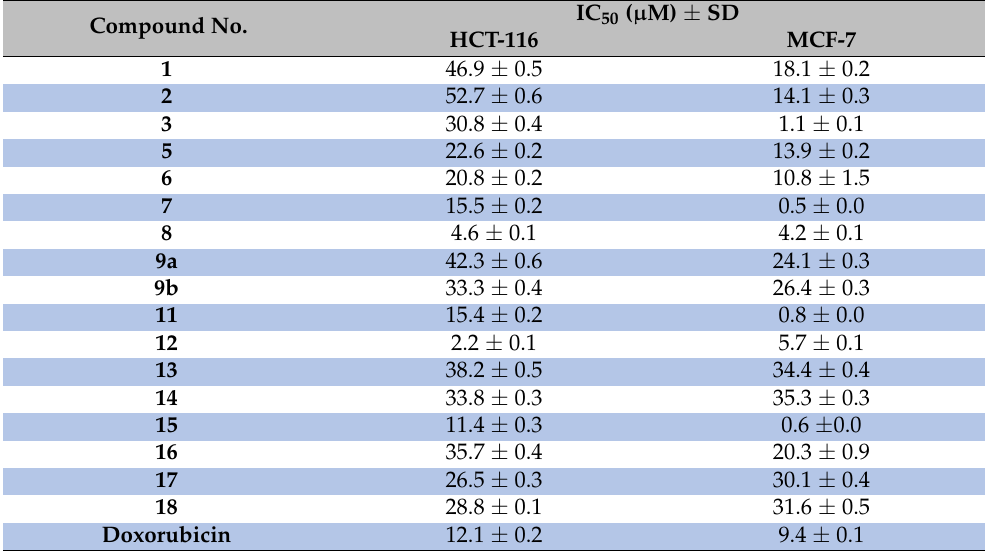
Table 1. IC 50 of the synthesized compounds against the two cancer cell lines according to the MTT